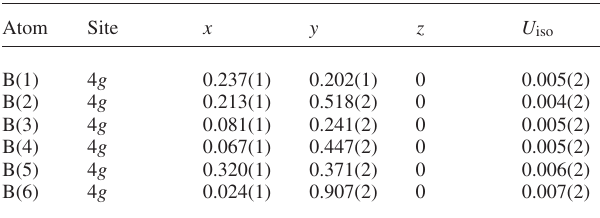
Table 2. Atomic coordinates and displacement parameters (in Å 2 )